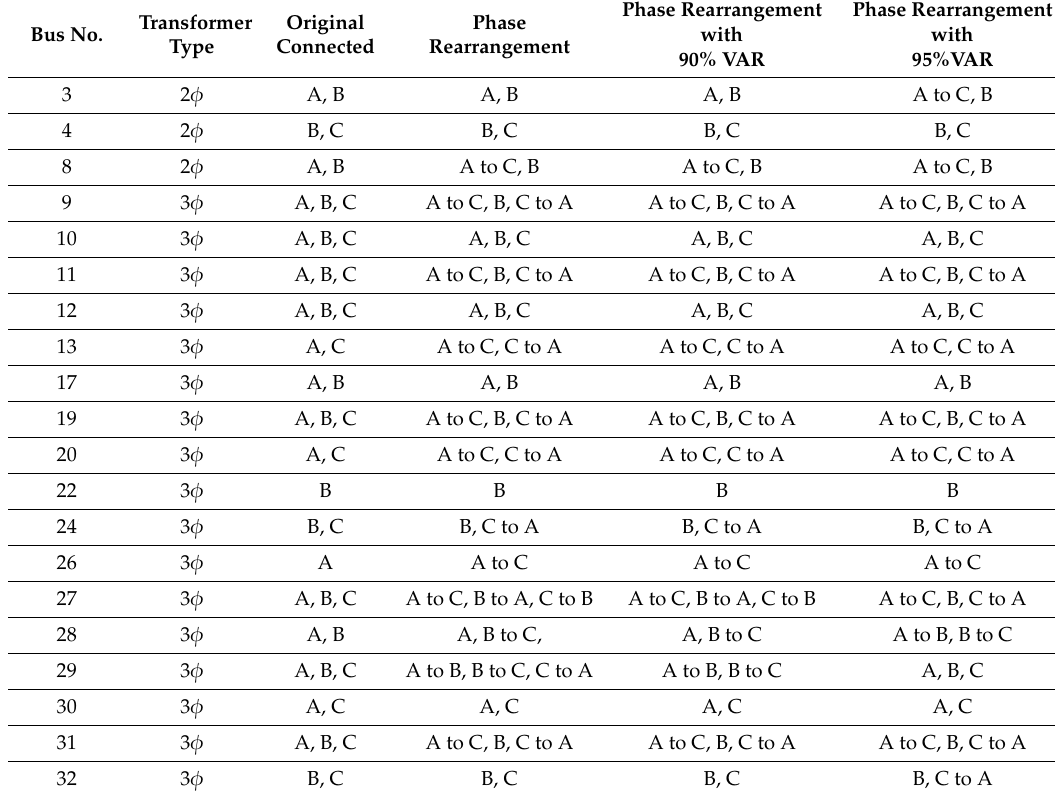
Table 4. The optimal phase connection of distribution